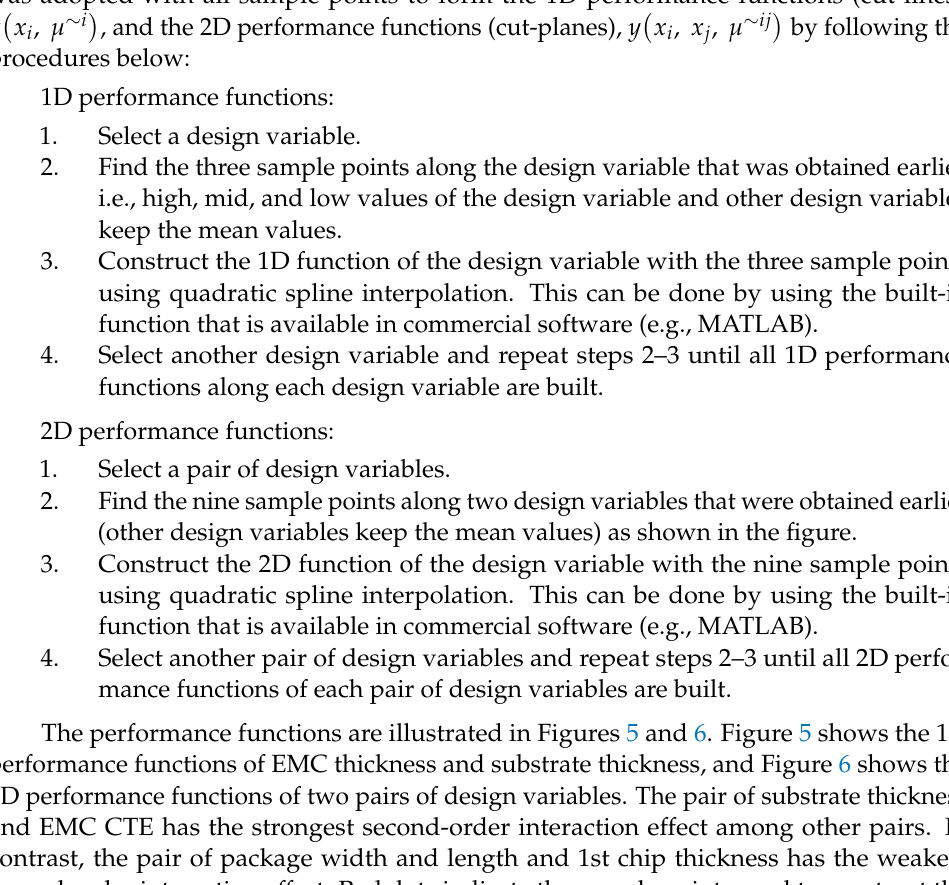
( b ) Figure 6. 2D performance functions of two pairs of design variables: ( a ) substrate thickness and EMC CTE, and ( b ) package width and length and 1st chip thickness.